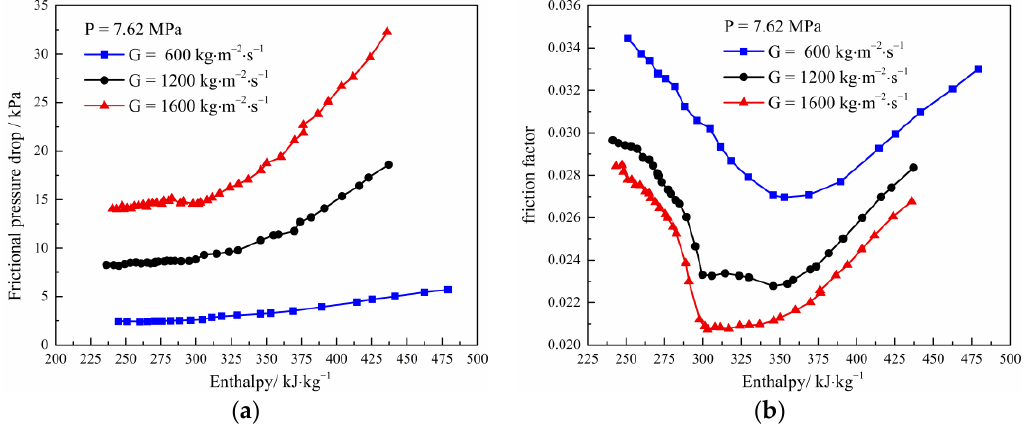
Figure 6. Effect of mass flux on friction pressure drop ( a ) and friction factor ( b ).